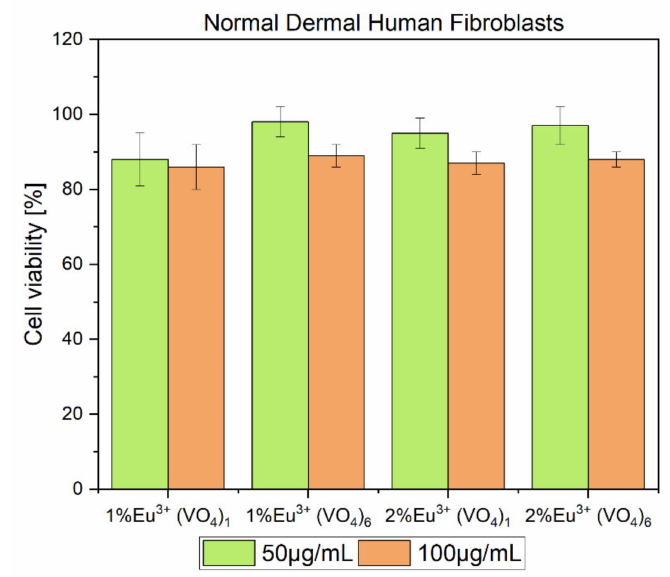
Figure 10. MTT cytotoxicity assay of compounds selected from the first series: Ca 9.9 Eu 0.1 (PO 4 ) 5 (VO 4 ) 1 (OH) 2 ,Ca 9.9 Eu 0.1 (VO 4 ) 6 (OH) 2 and second series: Ca 9.8 Eu 0.2 (PO 4 ) 5 (VO 4 ) 1 (OH) 2 ,Ca 9.8 Eu 0.1 (VO 4 ) 6 (OH) 2 . MTT assay was performed by using the NHDF cell line, the final concentration of the tested compounds in culture medium was estimated at 50 µ g/mL and 100 µ